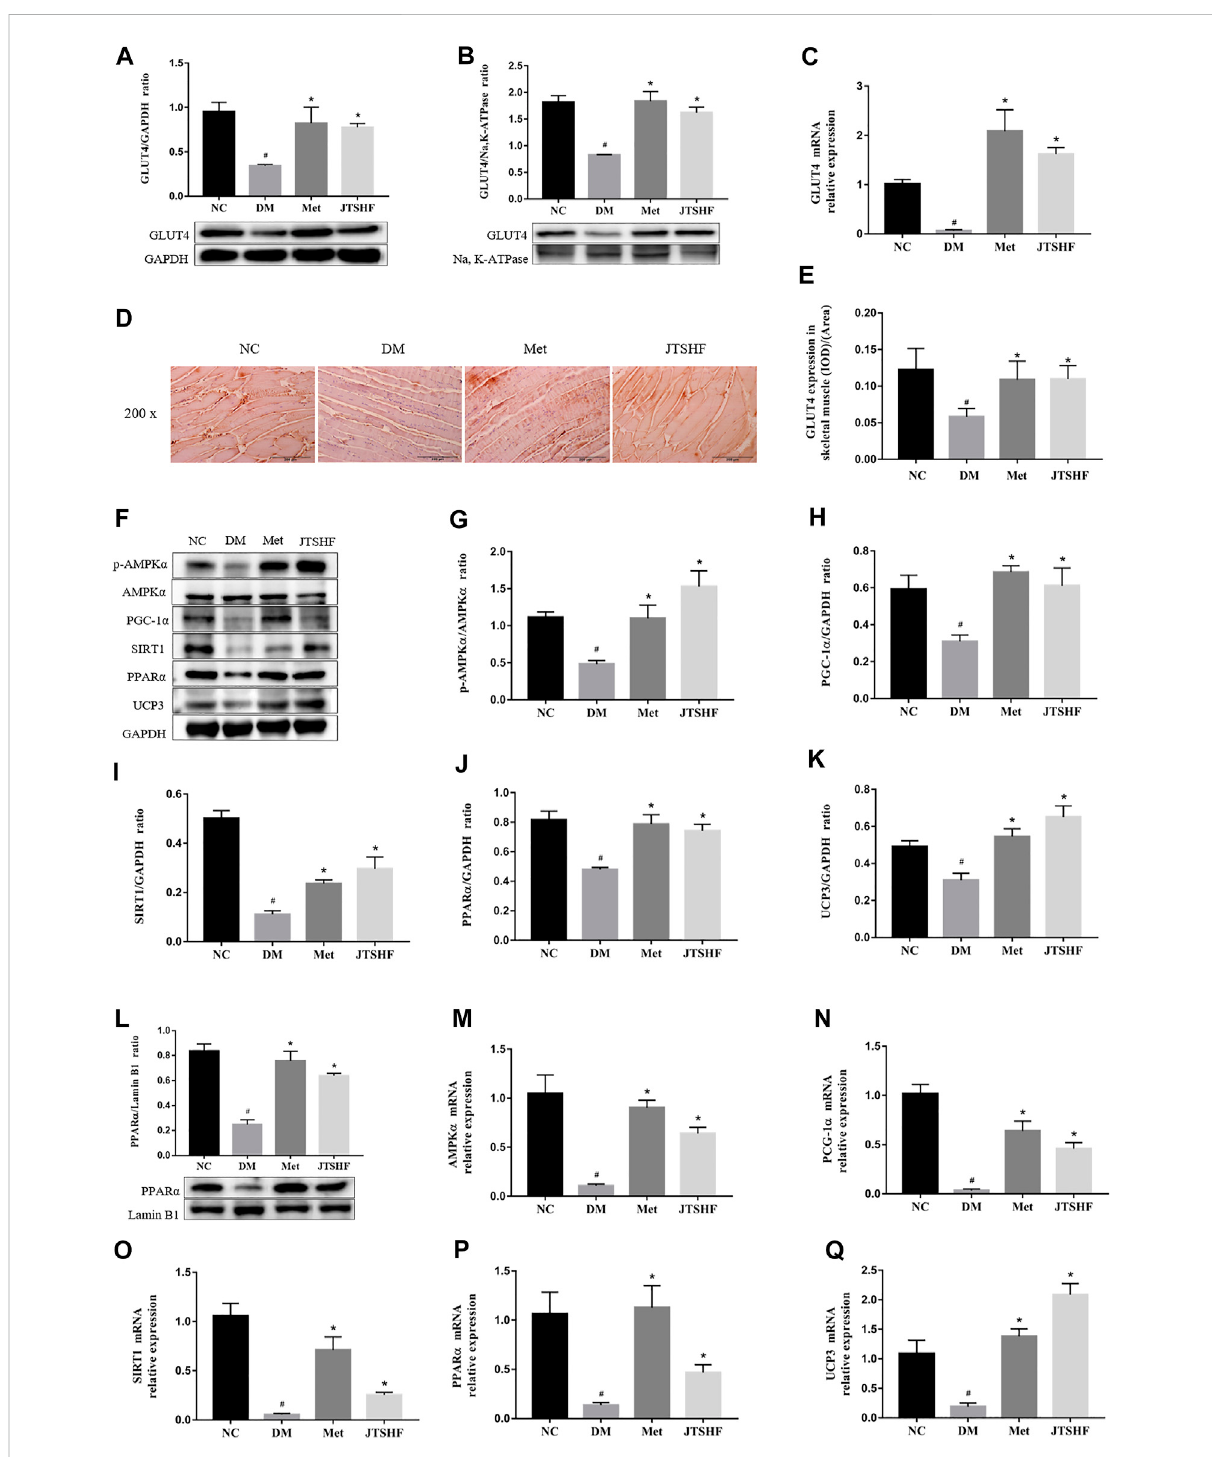
FIGURE 5 JTSHF promoted GLUT4 translocation by regulating AMPK α /SIRT1/PGC1 α signaling pathway in skeletal muscles of HFD-STZ induced diabetic mice. (A) and (B) Relative expression of protein GLUT4 (distributed in cytoplasm and membrane) and (C) gene expression of GLUT4. (D) and (E) Immunohistochemical results and mean density of GLUT4 (IOD/Area). (F – L) Proteins expressions of AMPK α , p-AMPK α , PGC-1 α , SIRT1, PPAR α (distributed in cytoplasm and nucleus), and UCP3. (M – Q) Genes expressions of AMPK α , PGC-1 α , SIRT1, PPAR α , and UCP3. All Values were expressed as mean ± SEM. # p < 0.05 versus NC group, * p < 0.05 versus DM group; n = 3 for each group in A,B, G – L; n = 6 for each group in E; n = 4 – 5 for each group in C, M –